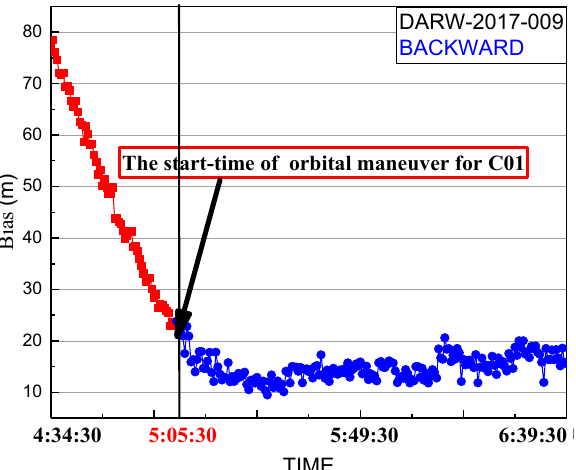
Figure 8. Spatial bias of pseudo-range single point positioning (SPP) coordinates on 9 January 2017. Coordinates are calculated by backward predicted orbit using the precise products on the day after orbital maneuvers. The red line is the series before the start time determined of maneuvering. The blue line is the series after the start time determined of maneuvering.